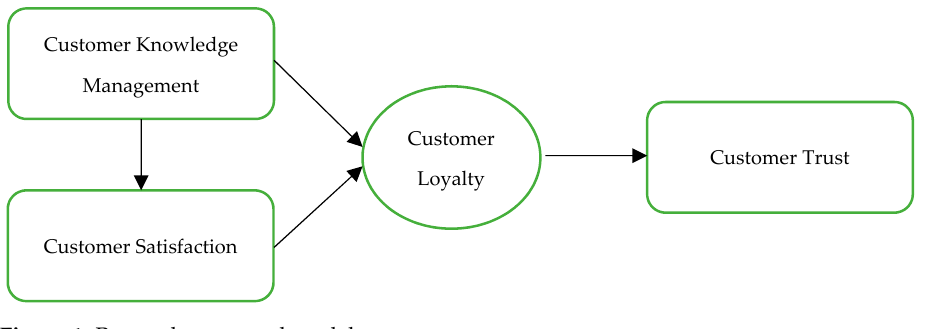
Figure 1. Research structural model.